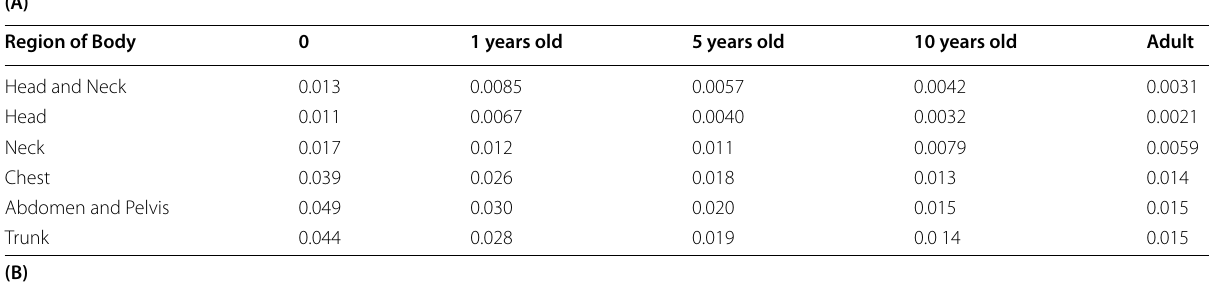
Table 1 (A) k ‑Factors in various tissues. (B) Calculation of effective dose in each exam